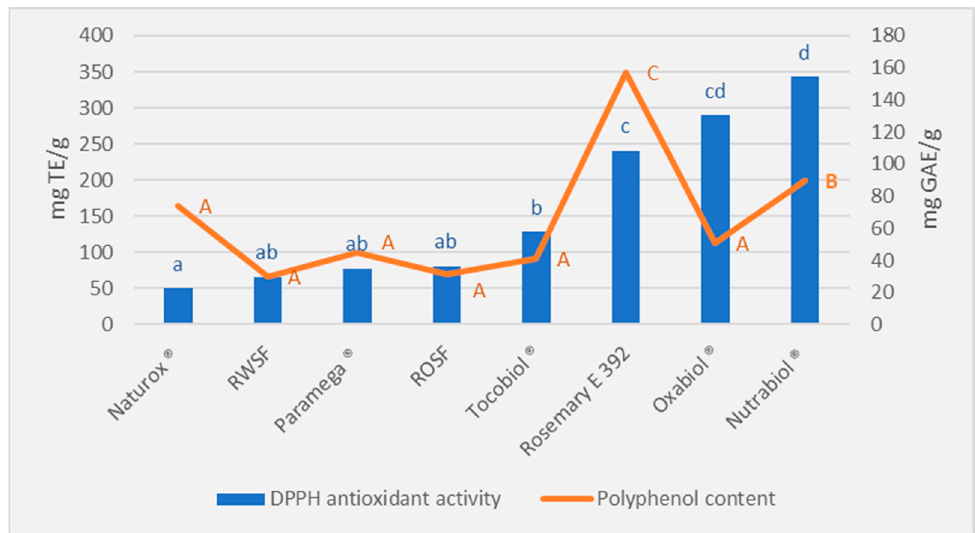
Figure 1. DPPH antioxidant activity and polyphenol content for different commercial antioxidant products. RWSF: rosemary water soluble fraction; ROSF: rosemary oil soluble fraction. Small letters indicate statistically significant differences ( p < 0.05) among products for the DPPH antioxidant activity. Capital letters indicate statistically significant differences ( p < 0.05) among products for the polyphenol content.